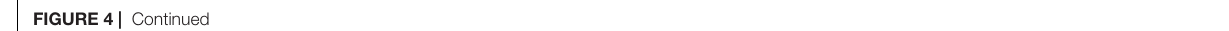
electrical synapse. (A) Serotonin (80 mM) was pressure-injected locally with a micropipette placed between a R cell pair in which either the coupling coefficient (cc) and the coupling conductance (g c ) or the gap junctional conductance (g j ) was continuously monitored (0.25 Hz) in one direction as described ( Figure 1